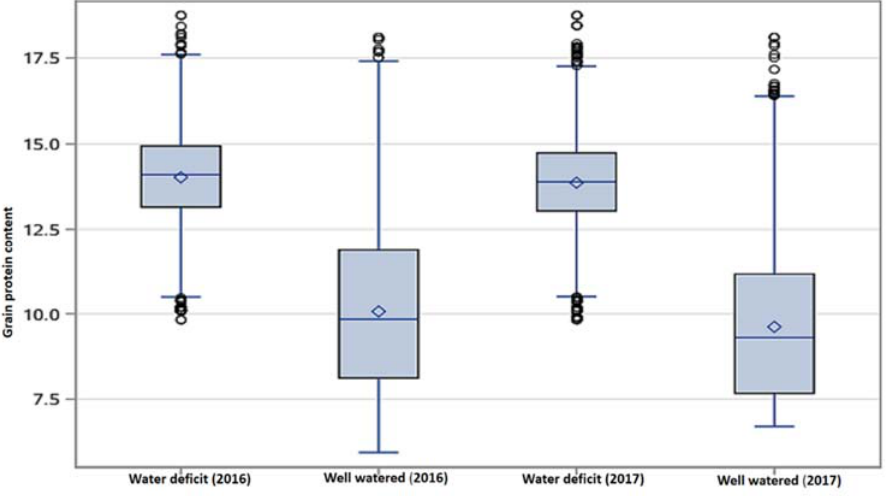
Figure 1. Boxplot for the overall performance of the 2111 wheat accessions across the four environments (well-watered and water-deficit conditions in 2016 and 2017 growing